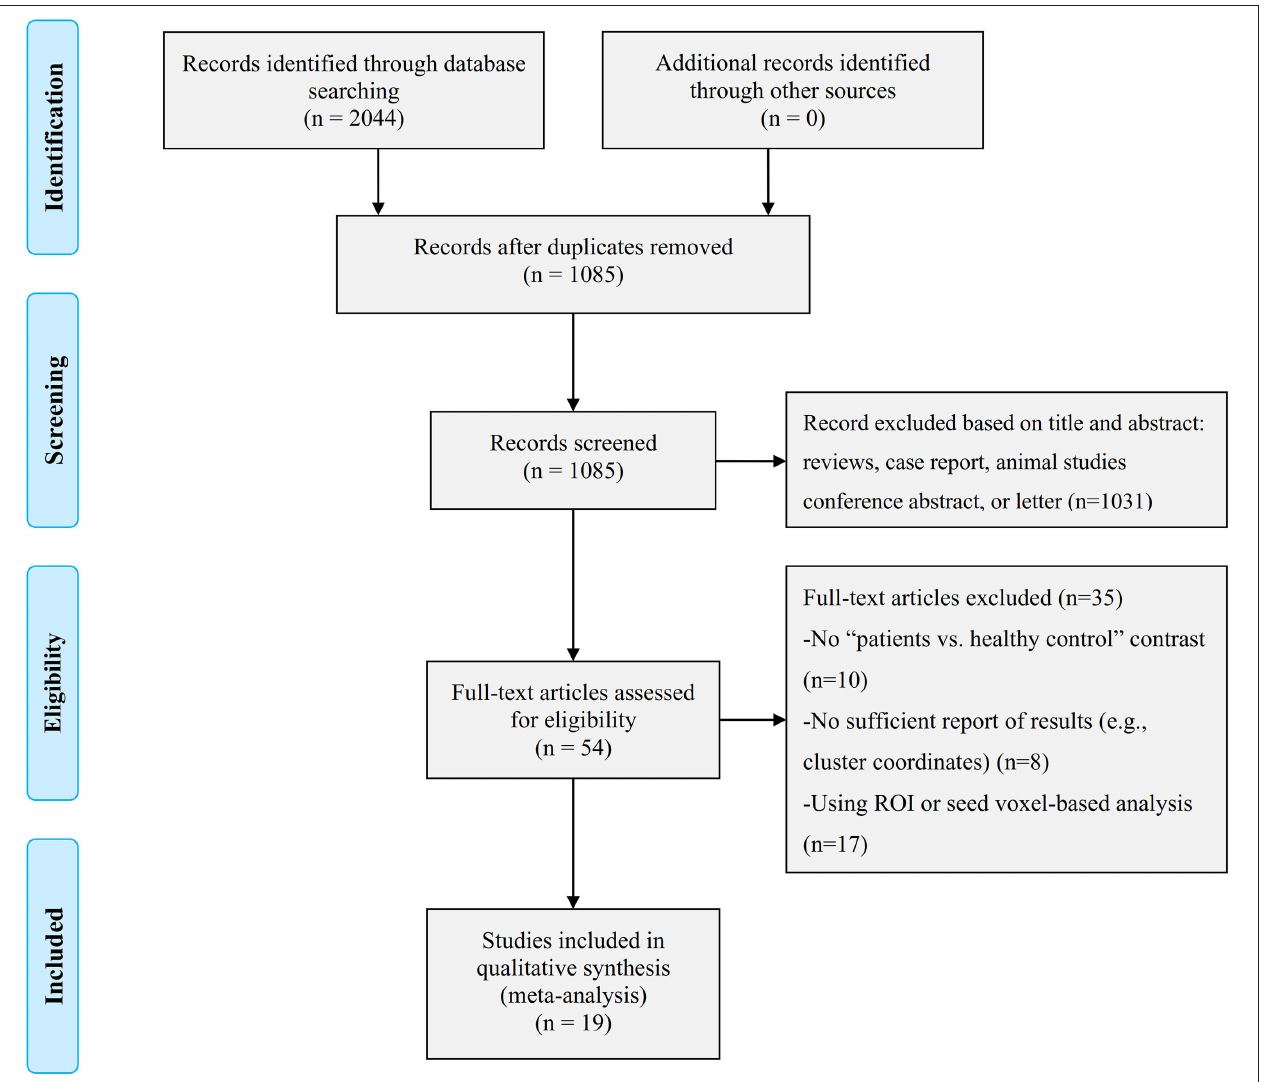
FIGURE 1 | Search strategy used for the inclusion of the studies considered in the current